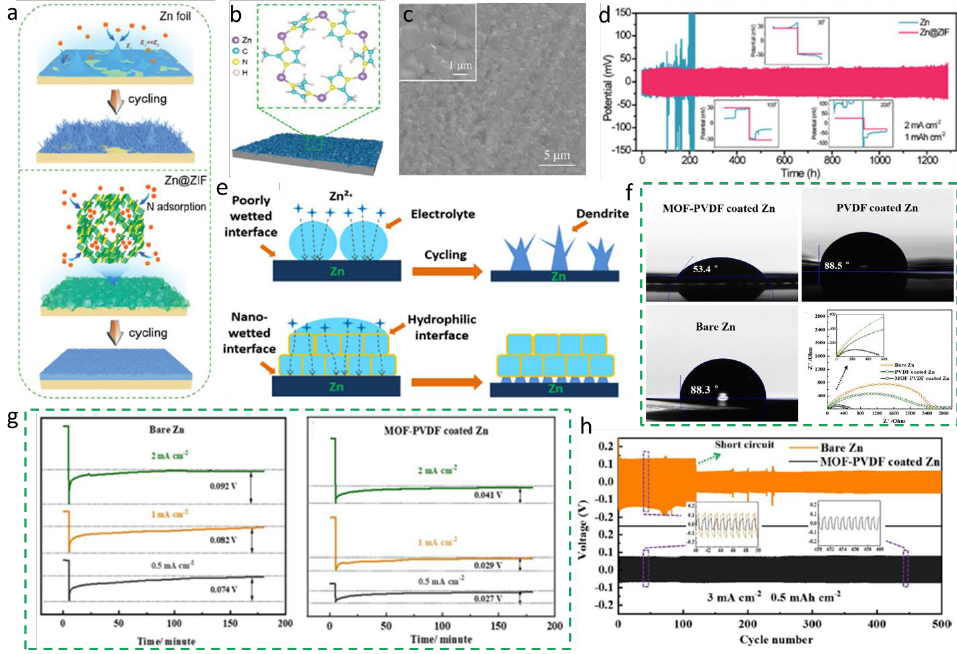
Figure 8. ( a ) Schematic diagram of the morphology evolution of bare Zn and ZIF@Zn anodes during cycling, ( b ) schematic illustration of the interaction between Zn and ZIF-8, ( c ) SEM image of the ZIF@Zn, and ( d ) voltage profile of symmetric bare Zn and Zn@ZIF cells at 2 mA cm − 2 with a capacity of 1 mAh cm − 2 . (Reproduced with permission [103] Copyright 2020, John Wiley & Son). ( e ) Schematic propose of Zn plating mechanism on bare Zn and UIO-66-coated Zn, ( f ) the contact angles between the electrolyte and different anodes as well as the electrochemical impedance spectra of Zn-symmetric cells, ( g ) Zn plating voltage curves for bare and coated Zn at various current densities, and ( h ) voltage profile of galvanostatic Zn plating/stripping at 3 mA cm − 2 for different Zn electrodes. (Reproduced with permission [106] Copyright 2019, American Chemical